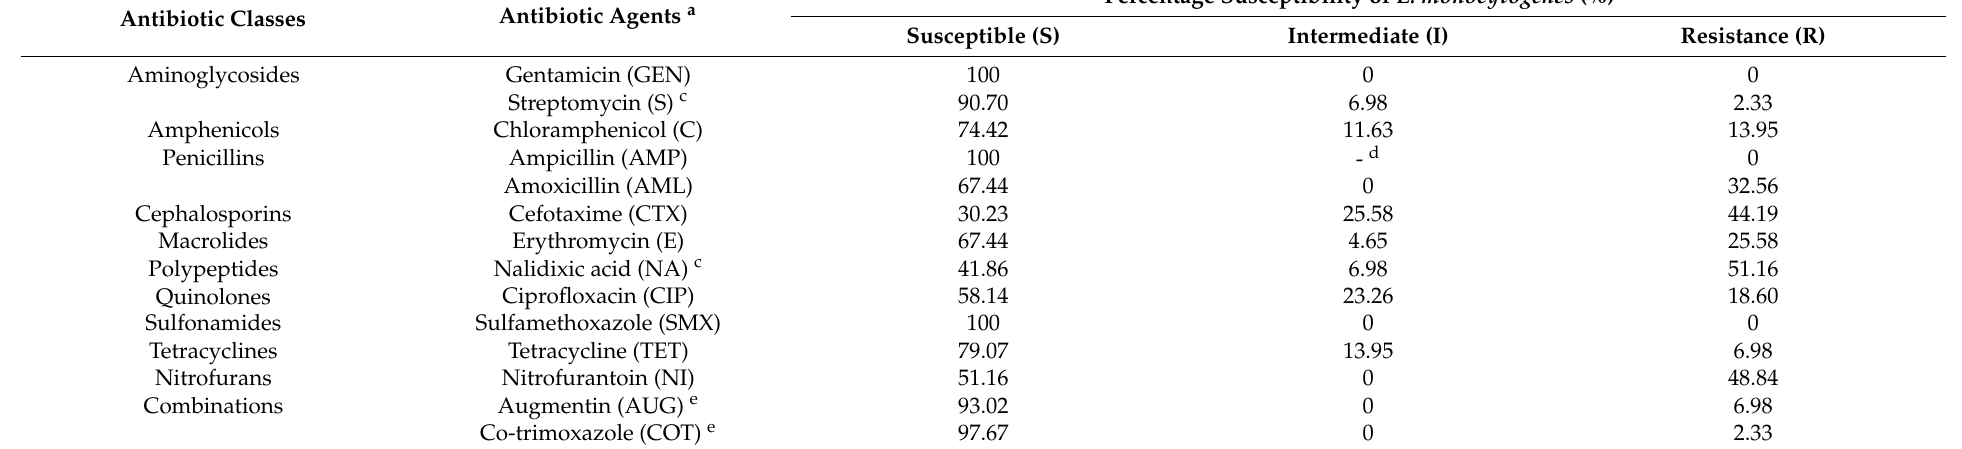
Table 1. Frequency of varying susceptibility of Listeria monocytogenes